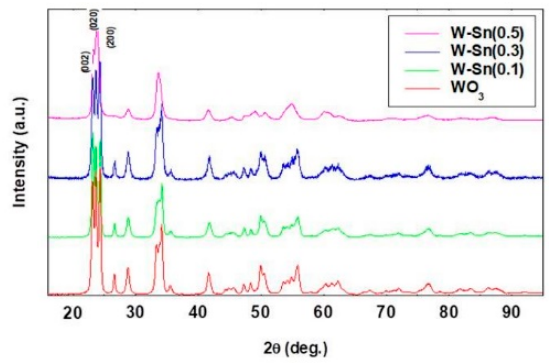
Figure 1. XRD pattern of pure WO 3 and W-Sn powders (nominal Sn molar fraction of 0.1, 0.3 and